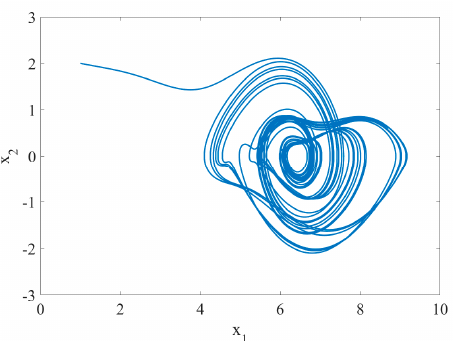
Figure 4. Phase diagram of chaotic System ( 1 )